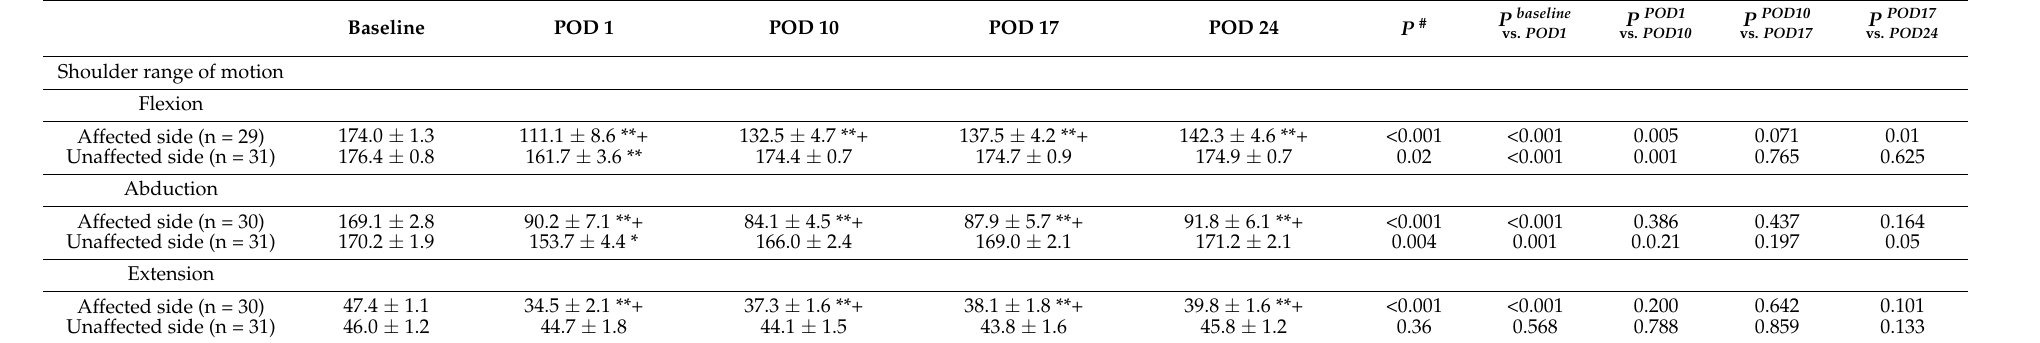
Table 2. Change of shoulder range of motion (pre-surgery to 4 weeks